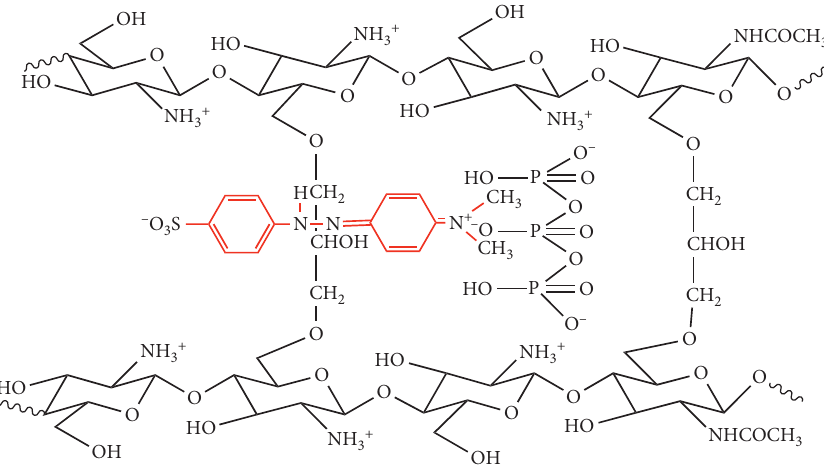
Figure 6: Adsorption mechanism of methyl orange onto cross-linked chitosan